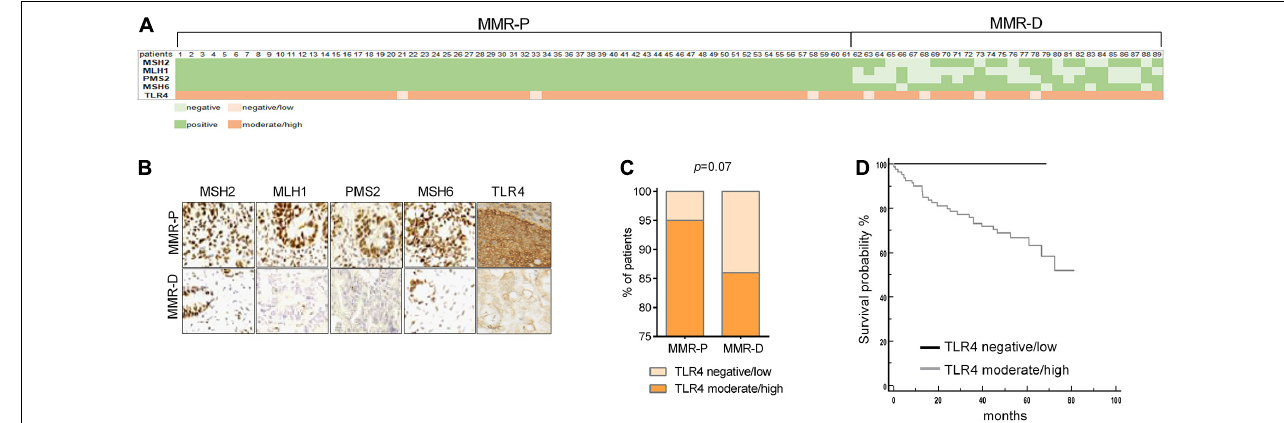
FIGURE 2 | Expression of TLR4 in a tissue microarray of colon cancer according to MMR status. (A) Heat map showing MMR genes expression (light green = no expression; dark green = expression). TLR4 expression was graded as low (no or mild expression = light orange) or high (moderate or high expression = dark orange). (B) Representative images of MMR genes and TLR4 expression according to the presence of MMR deficiency at immunohistochemistry: (C) data expressed as frequency of patients with low or high expression. (D) Kaplan-Meier estimate was used to perform the survival analysis and the log-rank test was used to compare groups according to TLR4